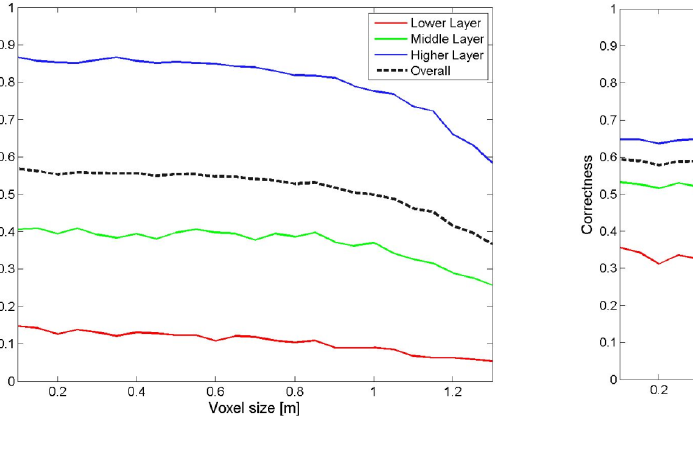
Figure 4. Sensitivity analysis with respect to the parameter acquired under leaf-off condition; ( a ) Completeness; ( b ) Correctness; colored lines indicate the forest